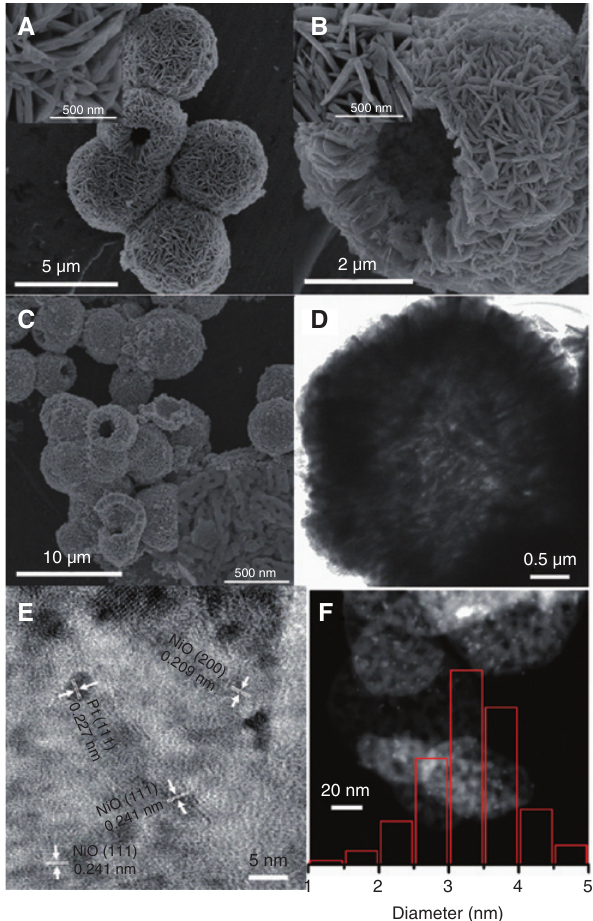
Figure 5: SEM images and the corresponding high-magnification SEM images (insets) of the samples: Ni80 (A), Ni400 (B) and Ni600 (C); TEM image of the Ni400P sample (D), HR-TEM image of an individual nanosheet in the Ni400P sample (E) and HAADF-STEM image of Ni400P (F). Inset scale bars = 500 nm. Reproduced from [31] with permission from Wiley-VCH.